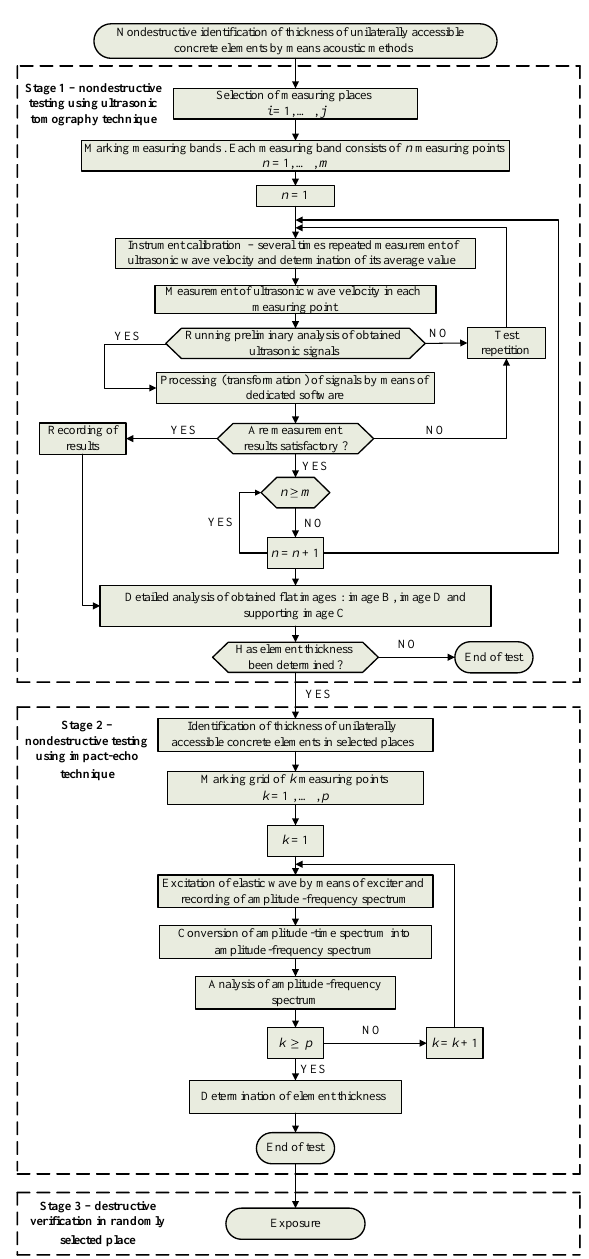
Fig. 5. Detailed diagram illustrating methodology for